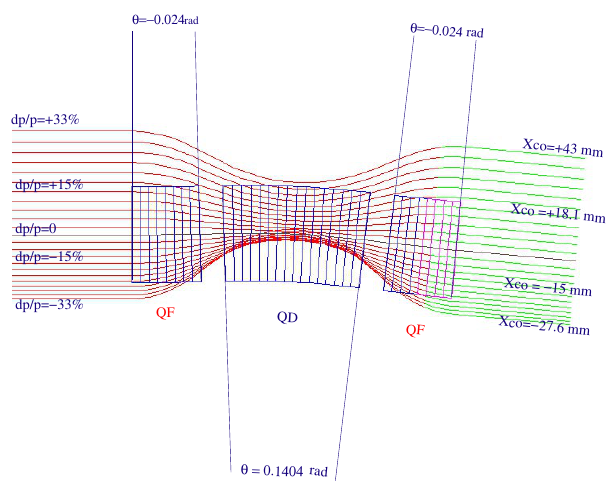
FIG. 13. (Color) Orbit offsets obtained by the polymorphic tracking code in one of the FFAG examples.